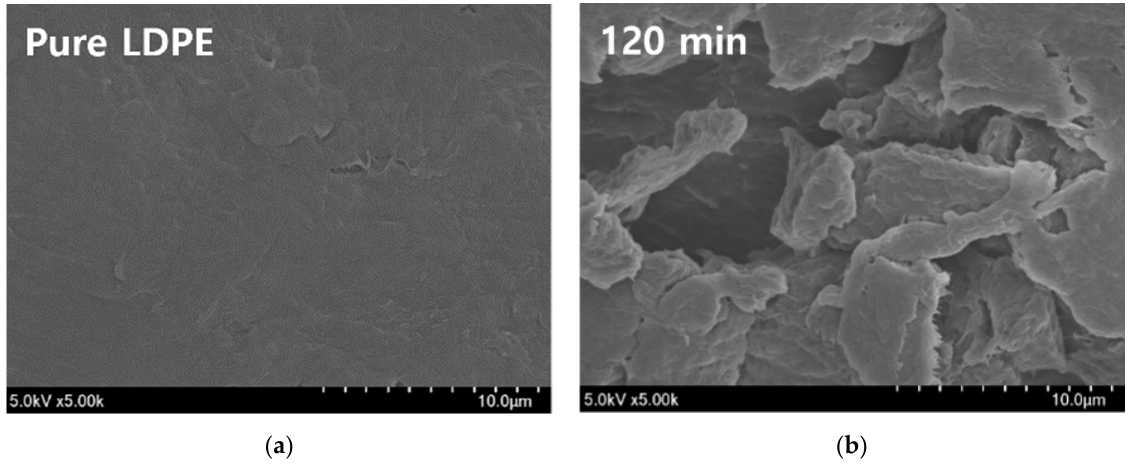
Figure 8. SEM images of LDPE samples at different treatment times ( a ) pure LDPE ( b ) 120 min.